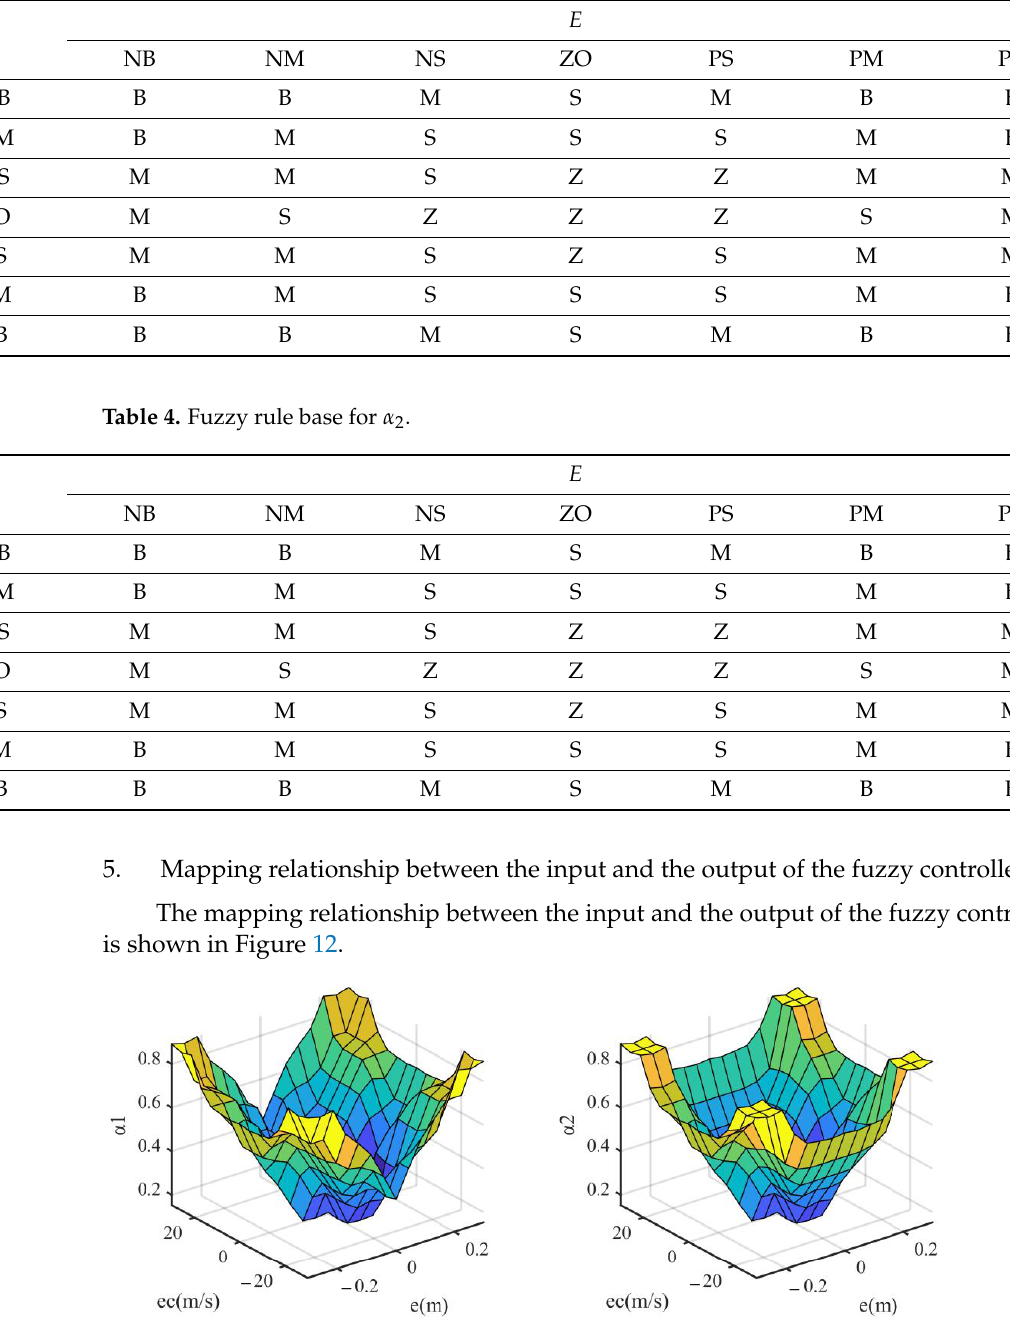
Table 3. Fuzzy rule base for α 1 .